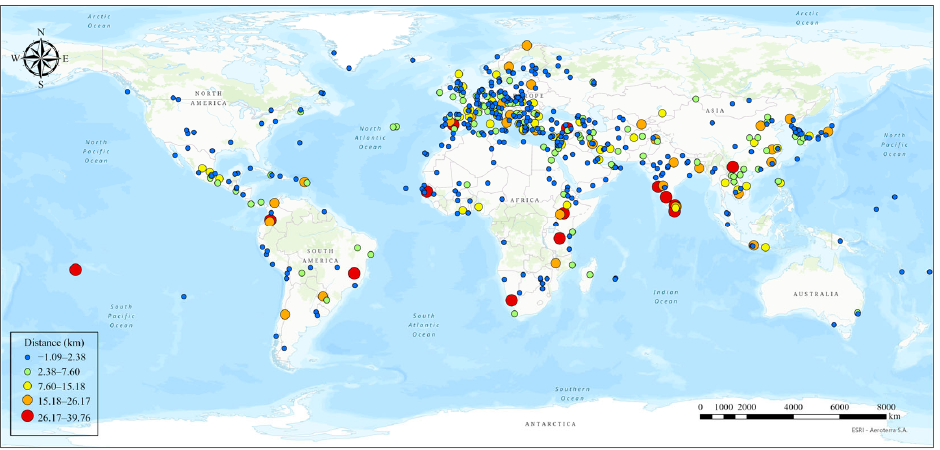
Figure 7. Distance variation between world cultural heritage sites and neighbouring towns in 1990–2018.